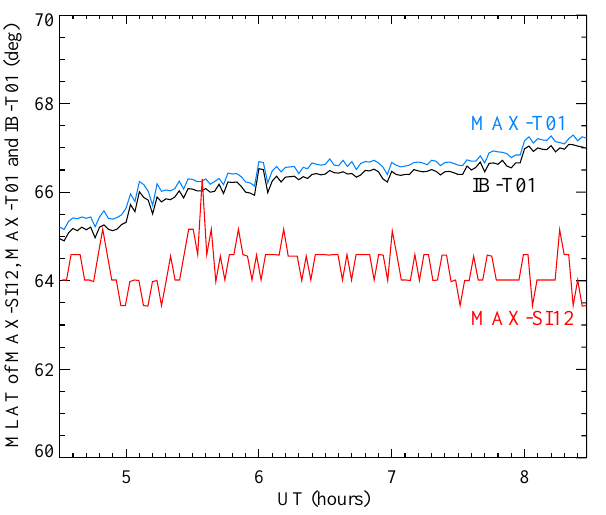
Fig. 1. Evolution of the magnetic latitude of the SI12 maxi- mum proton precipitation (red line) during a 4-h quiet period on 5 November 2000, compared with the location of the IB ( R =8) (black line) and the maximum intensity ( R =6) (blue line) calculated by the T01 model.